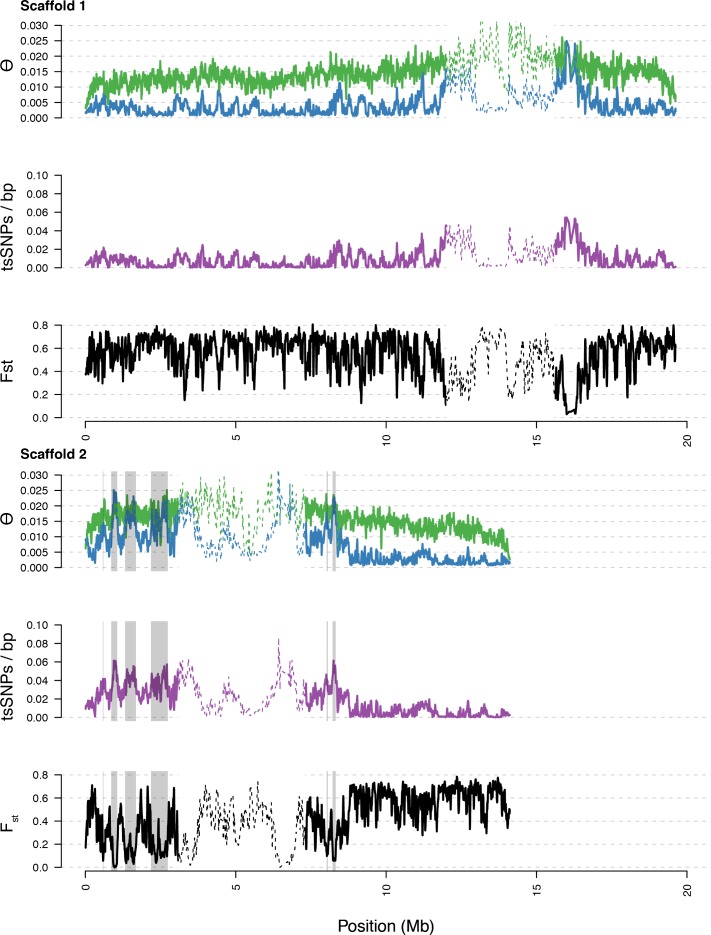
Diversity in C. rubella and C. grandiflora along scaffolds (chromosomes) 1 and 2.Data calculated in 20 kb windows, 5 kb steps. Windows with fewer than 5000 covered sites were masked for all calculations. Dotted lines indicate the pericentromeric regions excluded from our analysis, and shaded regions highlight the regions with significant evidence for balancing selection.